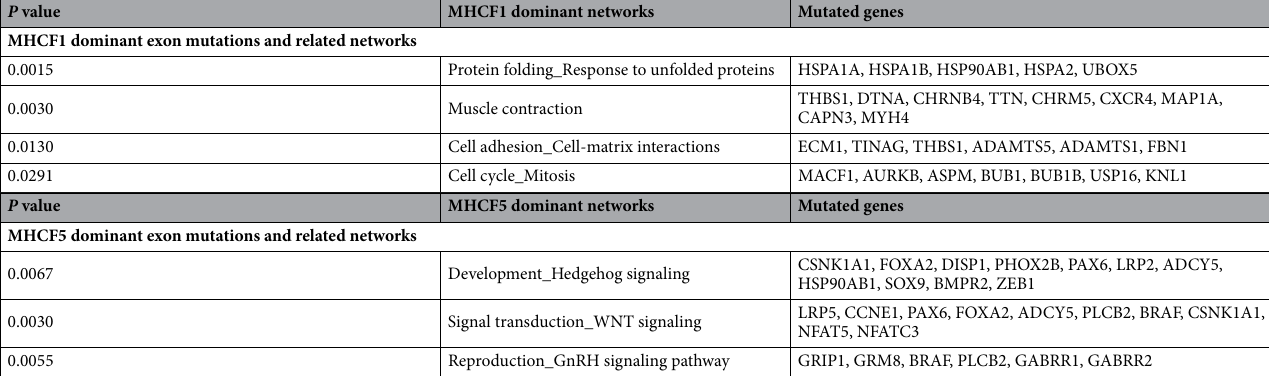
Table 3. Differential exon mutations between MHCF1 and MHCF2 cells and related